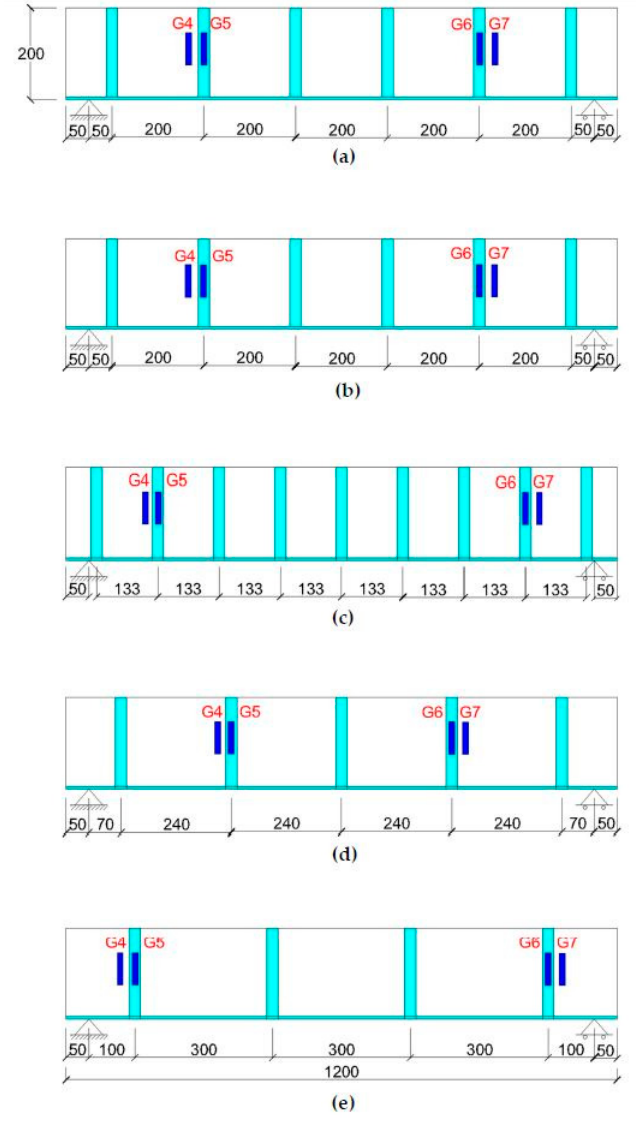
Figure 3. Position of strain gauges for shear: ( a ) B2, ( b ) B3, ( c ) B4, ( d ) B5 and ( e ) B6.